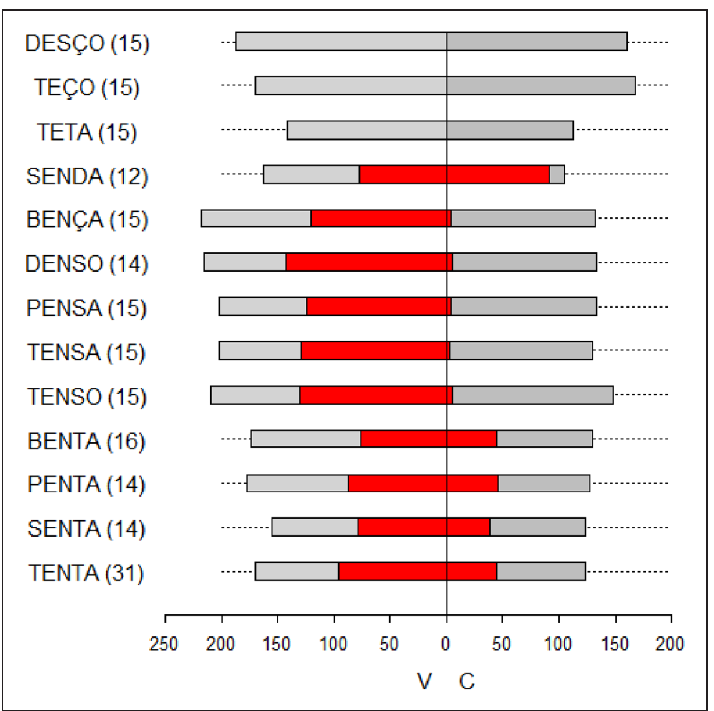
Figure 3: Mean duration (ms) of the oral and nasalized (in red) portions of vowels (light grey) and consonants (grey) by word (n of tokens). Zero marks the end of the